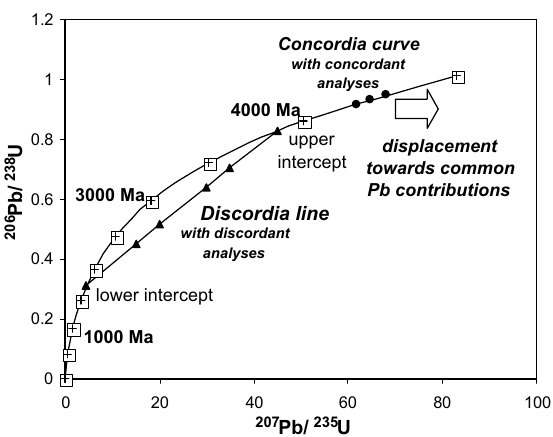
Fig. 1 – Principles of the Concordia diagram 207 Pb/ 235 U versus 206 Pb/ 238 U. Concordant analyses fall on the Concordia curve. Min- erals with a contribution of common Pb to the bulk Pb content plot below the Concordia curve. Lead loss leads to zircon analyses plot- ting on a Discordia line with the upper intercept indicating the age of